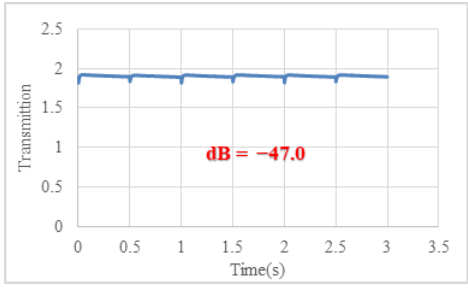
Figure 4. Determination of transmission and flicker of G.